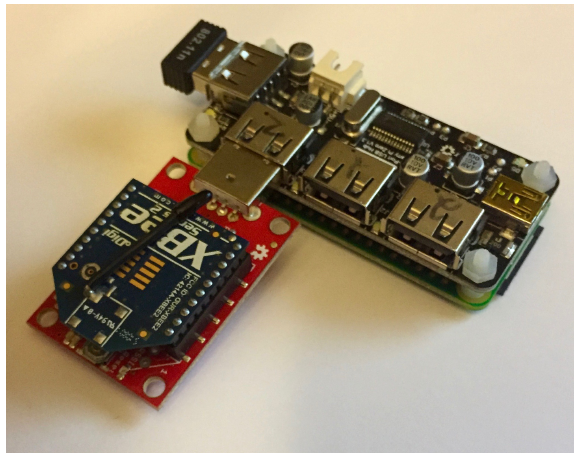
Figure 10. Photograph of Raspberry Pi Zero-based sensor node hardware.